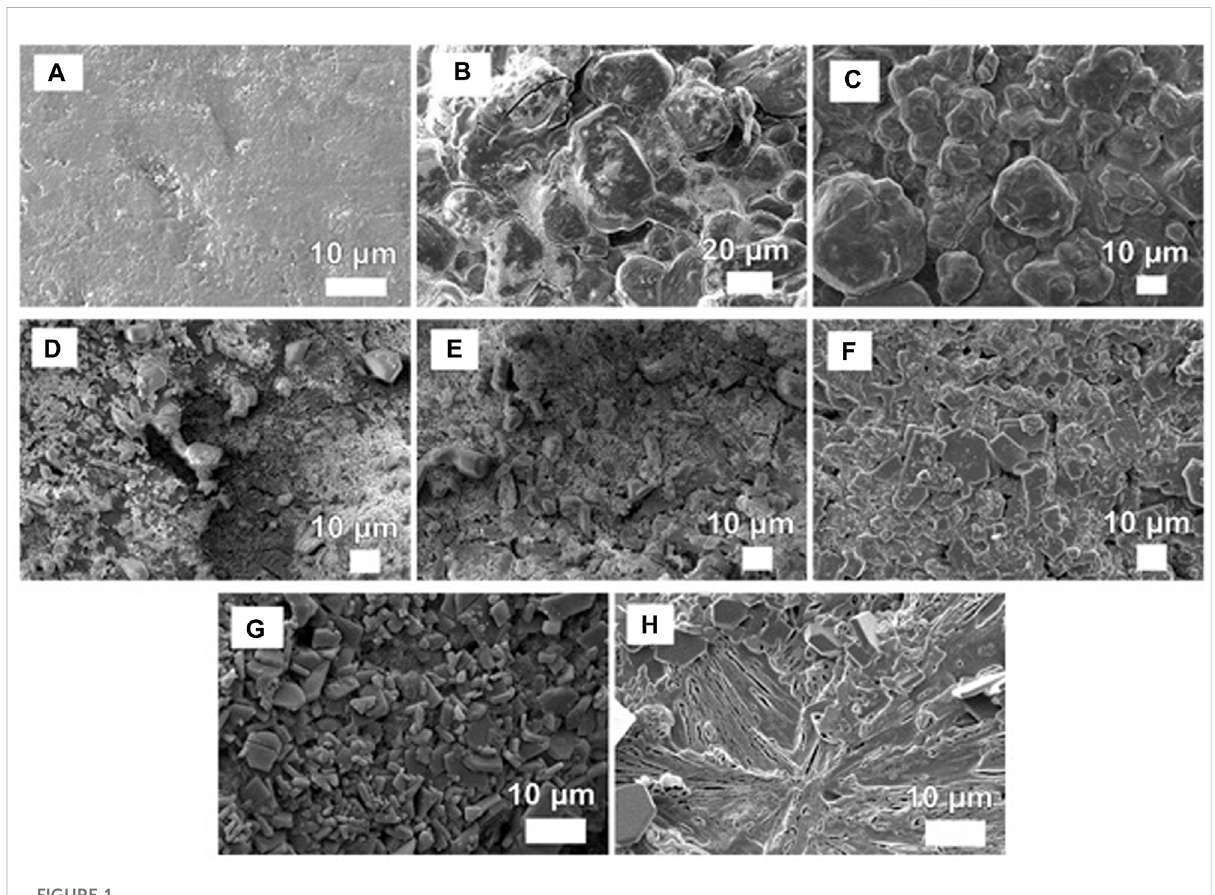
FIGURE 1 SEM images of fertilizer samples. (A) UC, (B) ZnS, (C) ZnSM, (D) ZnO, (E) ZnO-Son, (F) ZnOM, (G) ZnOG, and (H)